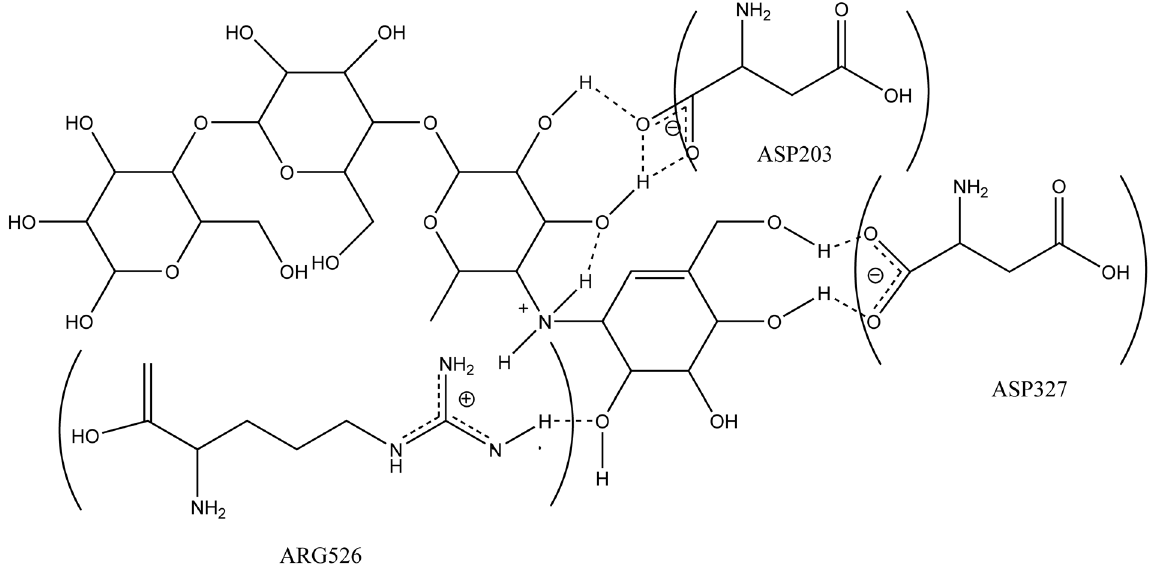
Figure 1. ntMGAM-acarbose interactions. Schematic representation of interactions (dotted lines) between the ntMGAM side chain residues and acarbose. (PDB entry 2QMJ).